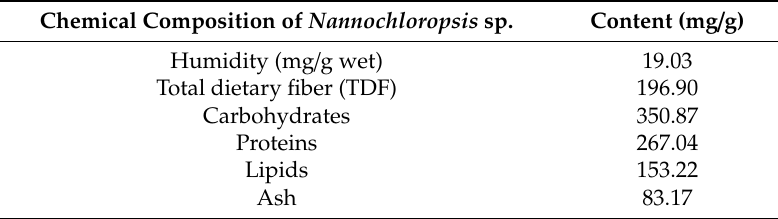
Table 4. Chemical composition of Nannochloropsis sp. biomass. Chemical Composition of Nannochloropsis